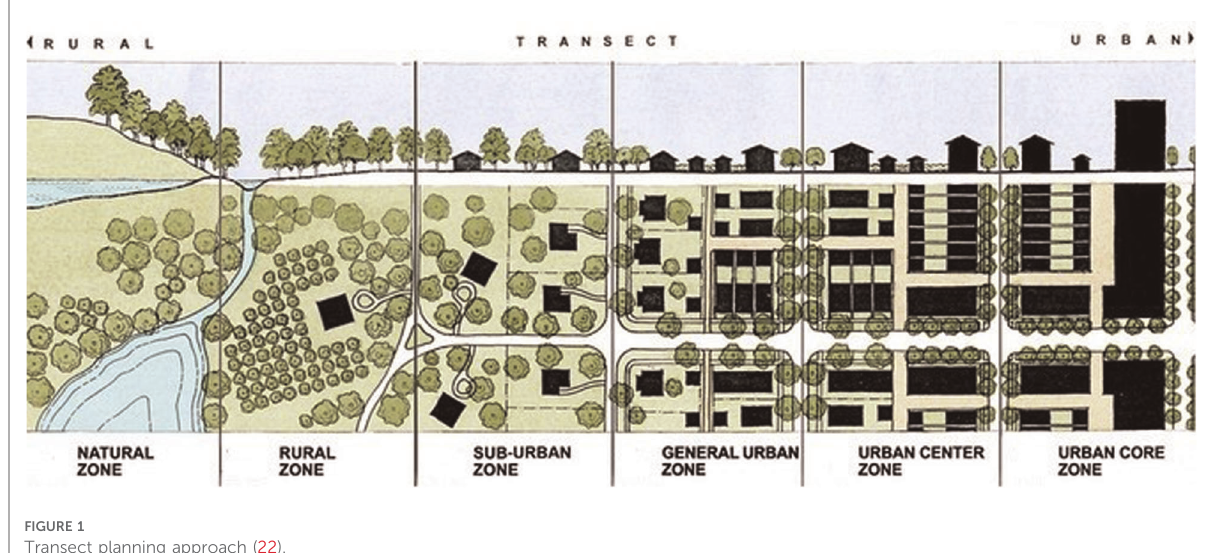
FIGURE 1 Transect planning approach (22).